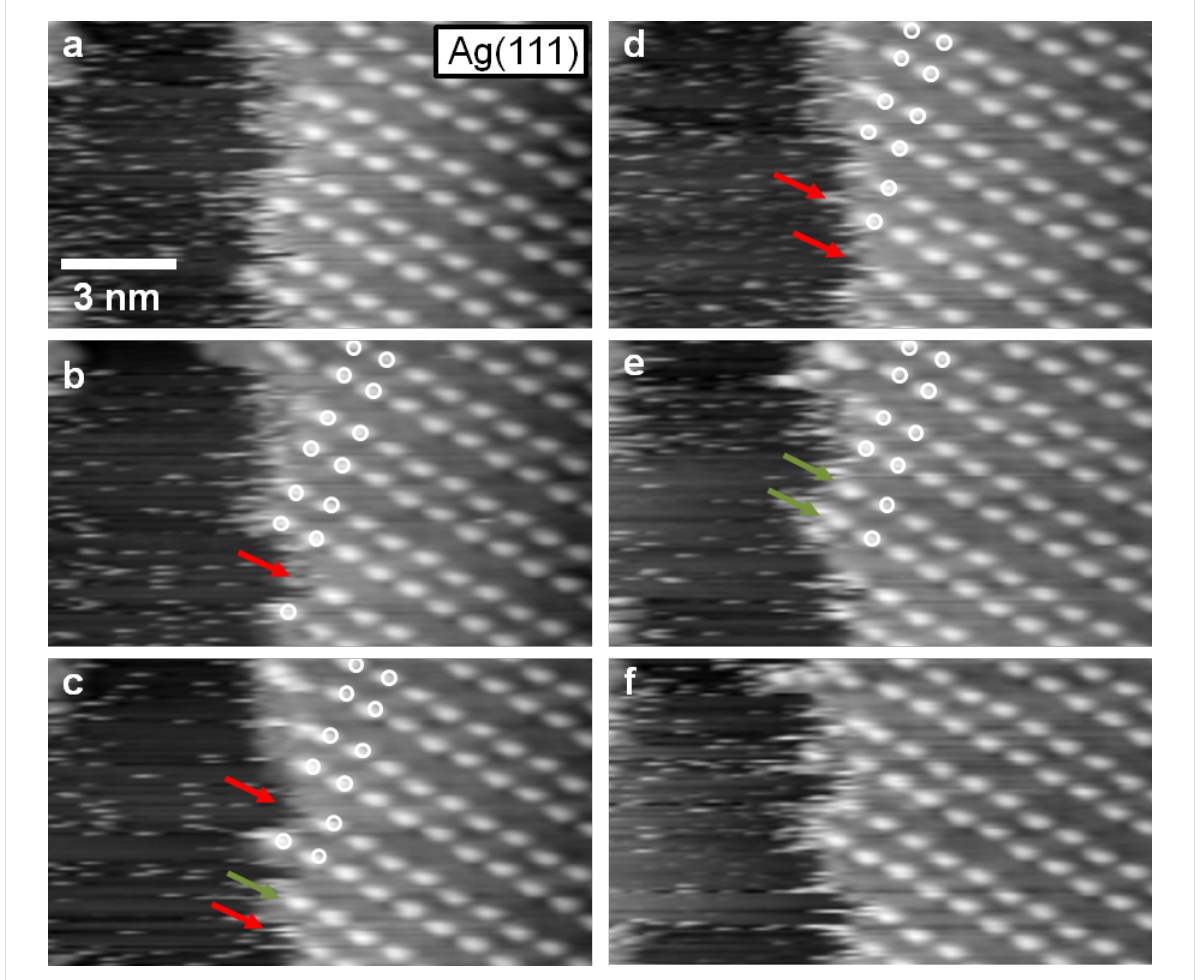
Figure 6: Time sequence of STM images at the phase boundary of the 2D crystalline phase of [BMP][TFSA] on Ag(111), recorded at 124 K (image to image time of ≈ 11 s) The images exhibit frizzy features directly at the 2D crystalline | 2D liquid interface, reflecting mobility of the adsorbed IL species, either along the island edge or in a 2D adsorption–desorption equilibrium. The red arrows in the images show places at the boundary, where round shaped protrusions vanish compared to the preceding image. The green arrows depict locations where a protrusion is attached to the boundary ( T = 124 K, U T = − 0.76 V, I T = 50